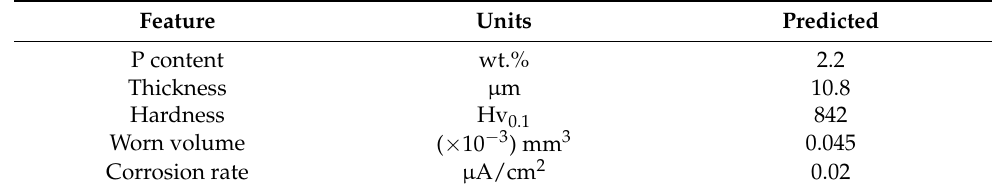
Table 9. Predicted values for all the properties subject to multivariate optimization.